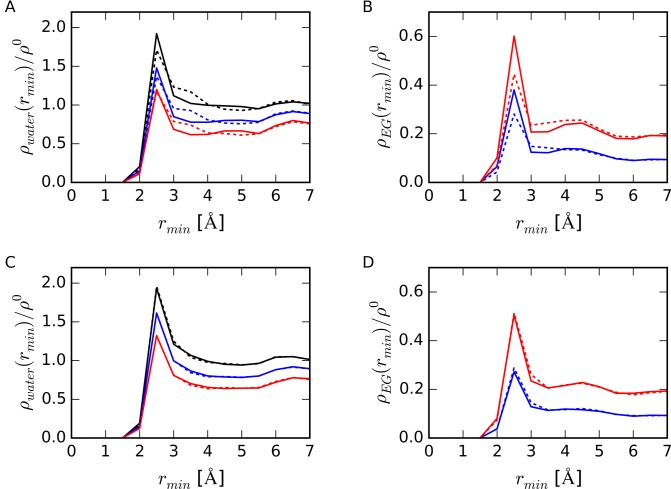
(A) Densities of water molecules near DNA strands relative to bulk water density, ρwater(rmin)/ρ0 and (B) relative number densities of EG molecule to bulk water, ρEG(rmin)/ρ0, around HP (solid lines) and TBA (dotted lines). (C) ρwater(rmin)/ρ0 and (D) ρEG(rmin)/ρ0 around unHP (solid lines) and unTBA (dotted lines). Bulk water density (ρ0) was set to 0.0329 Å−3. Black, blue and red lines represent data from 0.0 M, 2.5 M and 5.0 M EG concentrations, respectively.